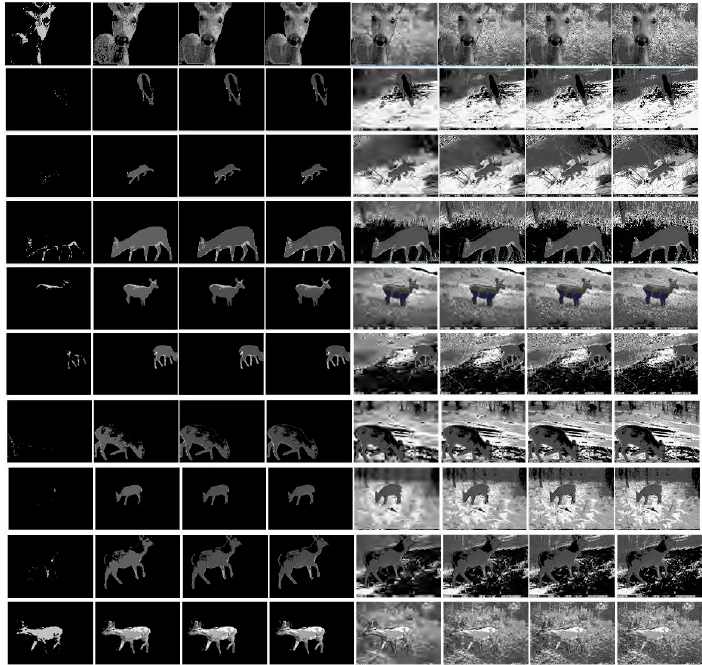
Figure 11. The flow chart of progressive transmission effect for wildlife images. The first 4 columns are the progressive transmission progress of saliency object region, and the last 4 columns are the progressive transmission progress of background region.